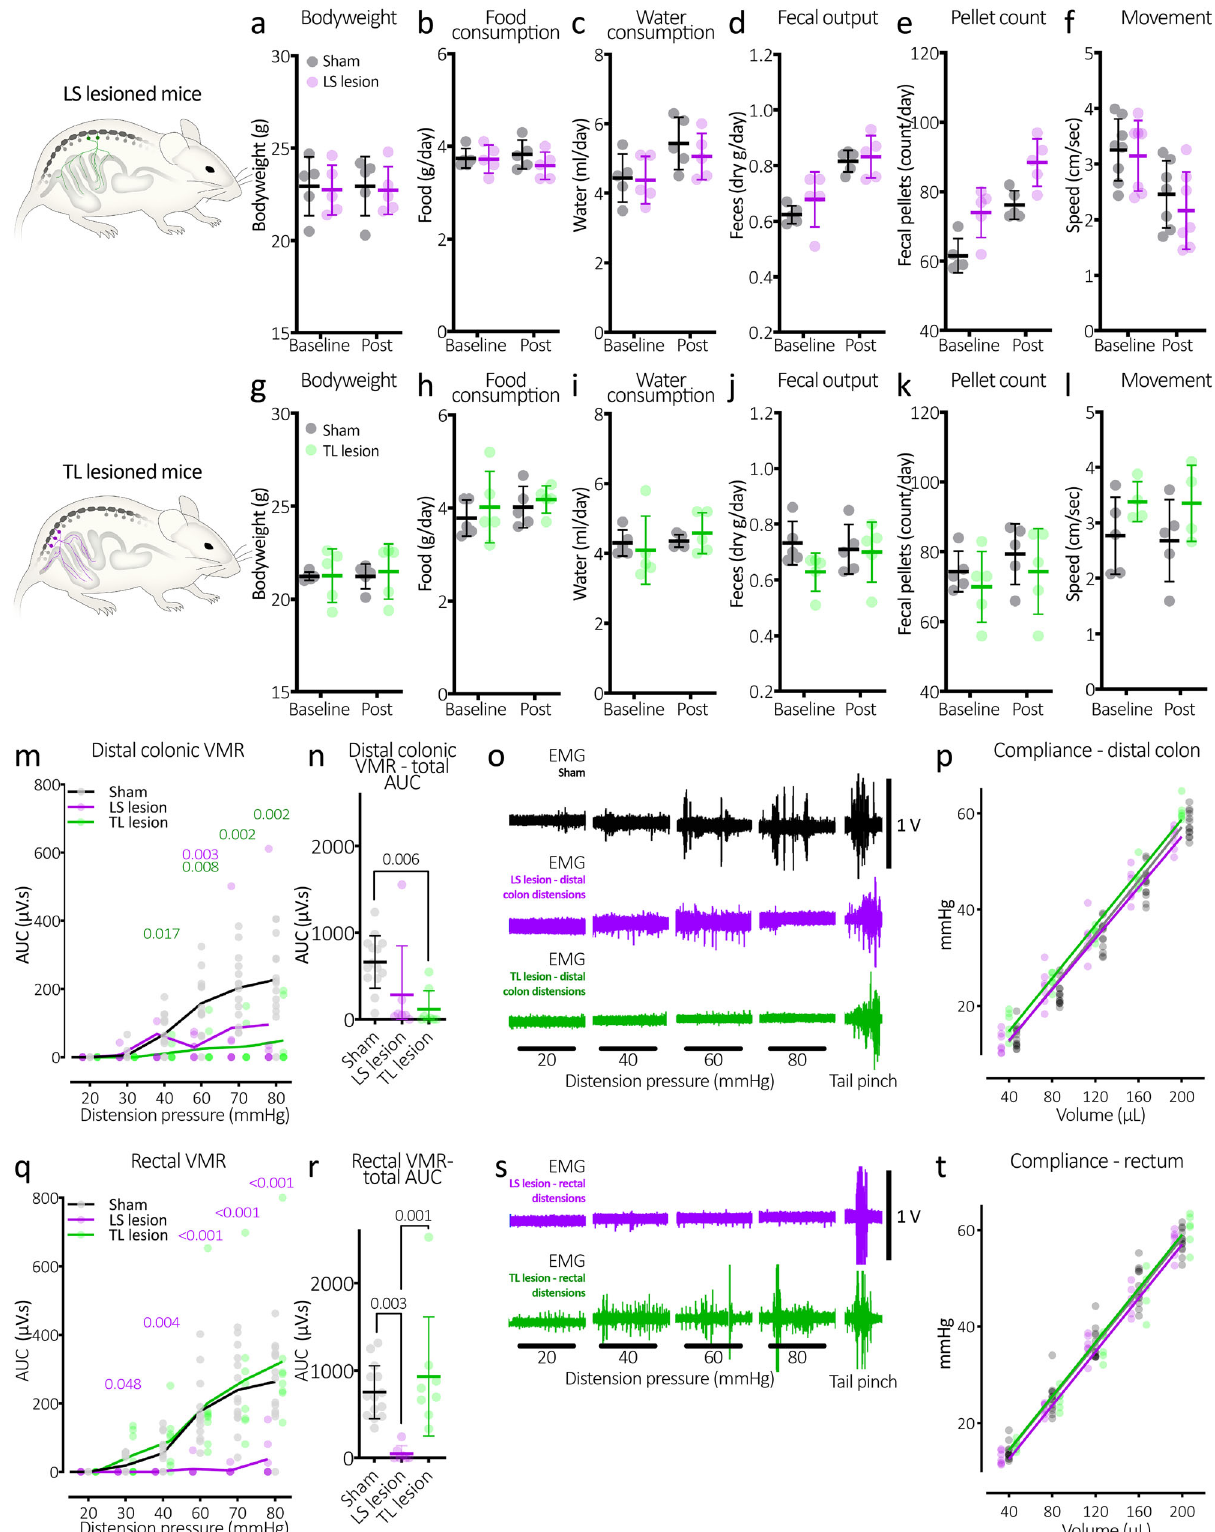
cord when LS DRG were removed. Notably, these very same ani- mals have unchanged neuronal activation within the TL dorsal horn region of the spinal cord. Conversely, in TL DRG-lesioned animals the number of activated dorsal horn neurons was reduced speci fi cally in the T13-L1 spinal levels and unchanged in the LS